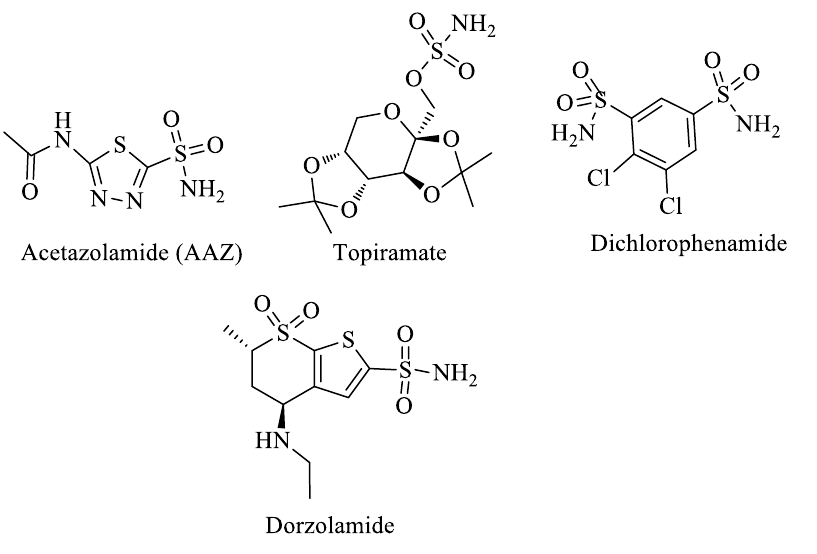
Figure 1. Known CA